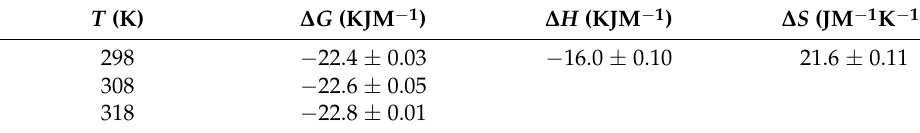
Figure 7. Van’t Hoff plot for the ( A ) HSA–cuminaldehyde and ( B ) HSA–cuminol interactions. Table 3. Thermodynamic parameters of HSA–cuminaldehyde interaction.